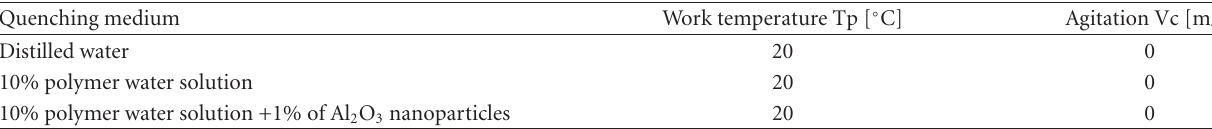
Table 1: Investigated quenching media.